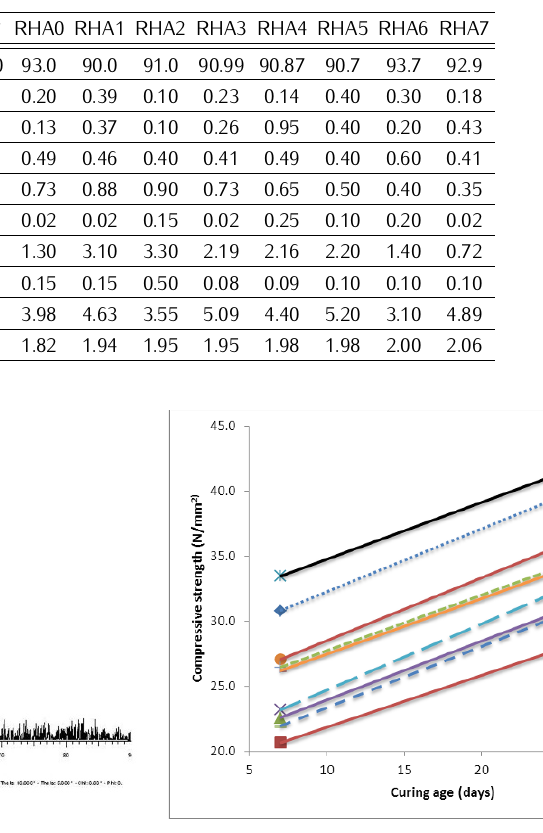
Table 4. Chemical composition and physical properties of the raw materials.